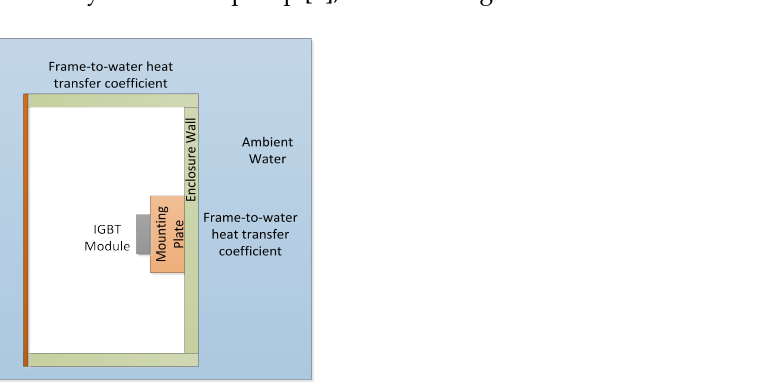
Figure 2. Passive cooling: IGBT module in a submerged and hermetically sealed power converter [5].